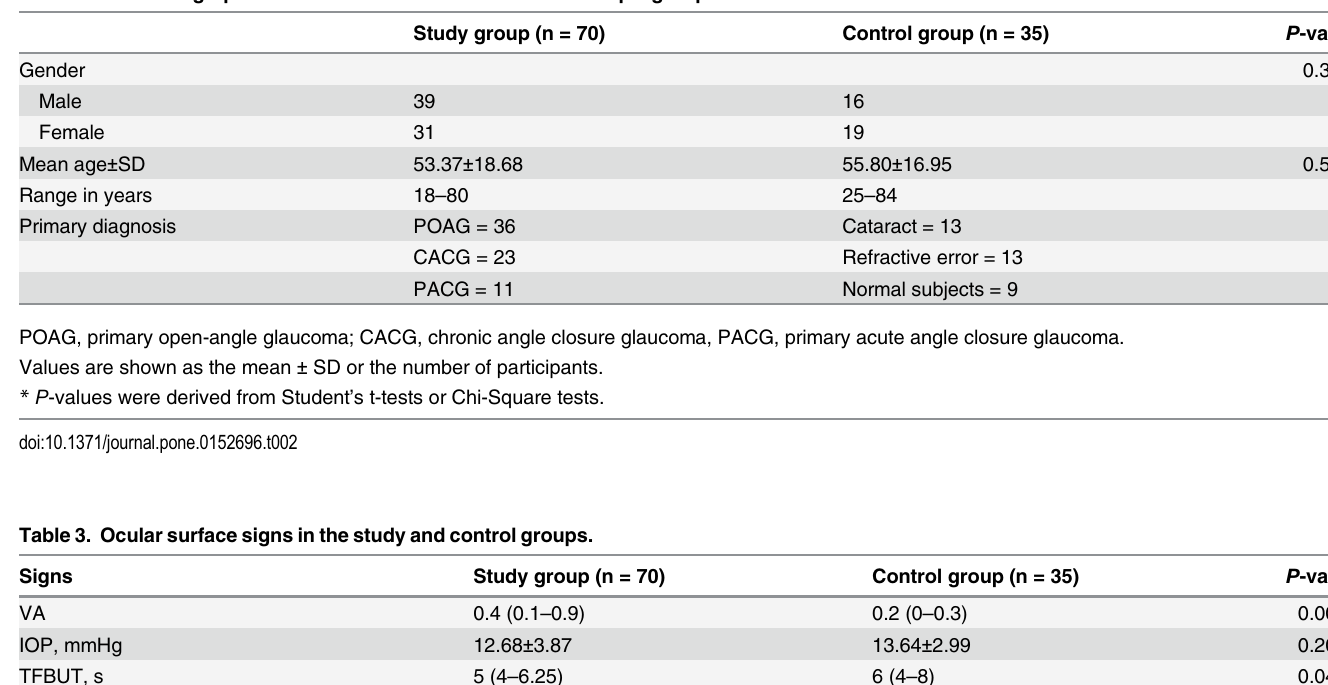
Table 2. The demographic and clinical characteristics of the sample groups.